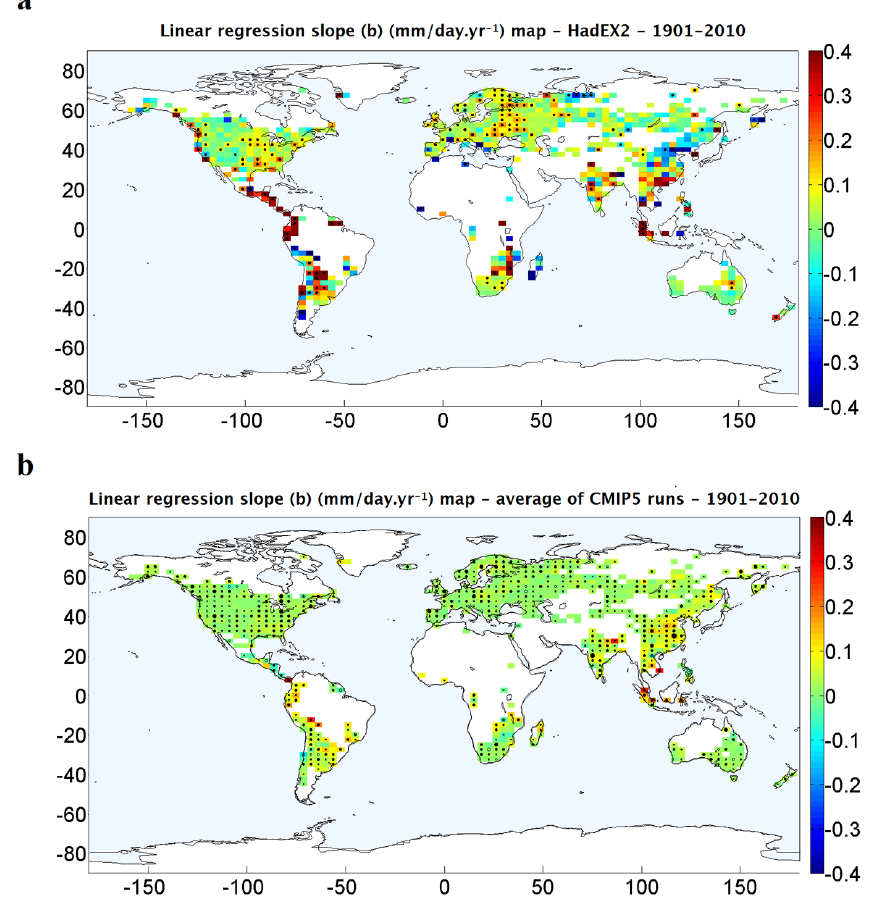
Figure 4. HadEX2 observational data versus CMIP5 averaged results of global extreme precipitation in 1901–2010 – linear regression slope of change in annual-maximum daily precipitation map (mmday − 1 yr − 1 ) for (a) HadEX2 and (b) the average of CMIP5 model runs. Stippling indicates significance of the calculated trend at the 95% confidence level. In cases of CMIP5 average maps, filled/empty stippling indicates a positive/negative trend on average. The larger marker size means a larger number of models agreeing on the presented trend, with the largest one indicating only 7 out of 19 model runs agreeing on the presented trend significance, which also implies the discrepancy in the trend significance between the climate